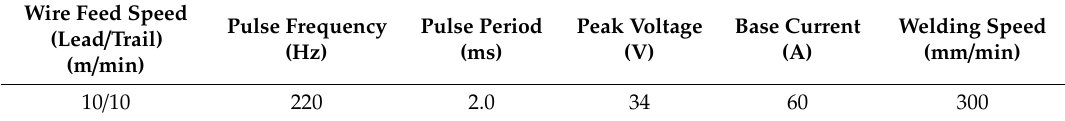
Table 2. Design of the shielding gas Table 1. Welding parameters.